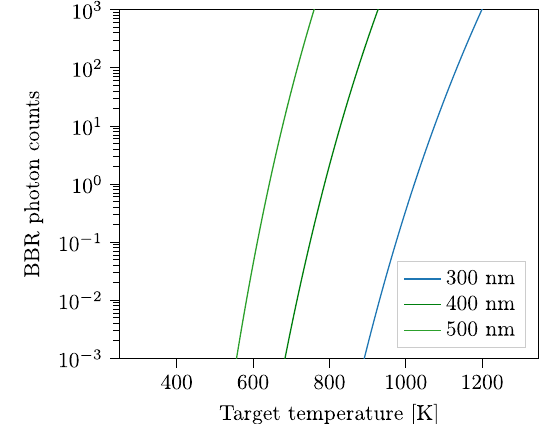
FIG. 16. Black body radiation as a function of target surface